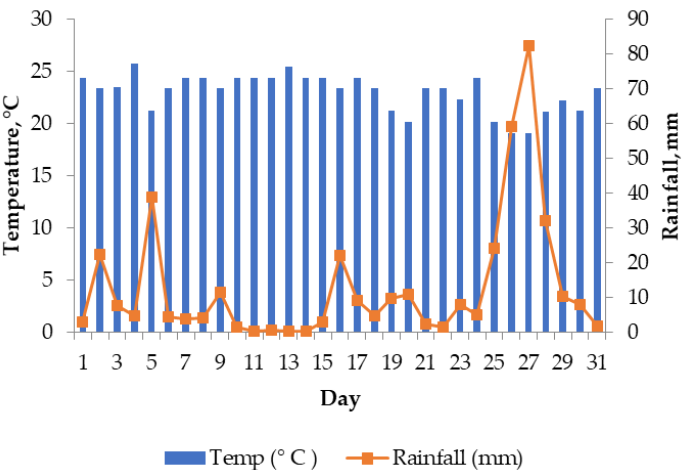
Figure 3. Daily mean temperature and rainfall data for the month of March, 2021.